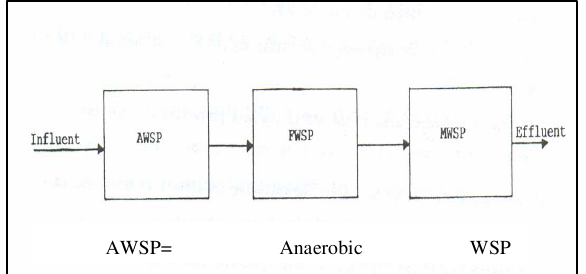
Figure 1 : Conventional layout of waste stabilization ponds